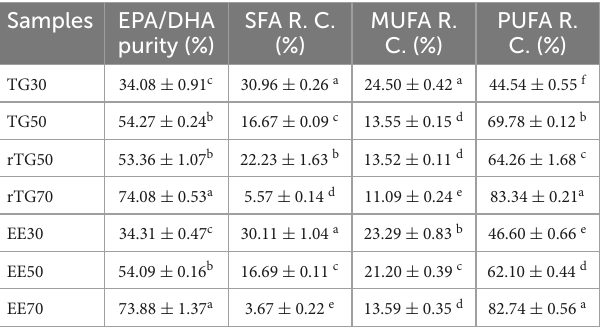
Valuesaremean ± SD, n =3.Valueswithdifferentsuperscriptsinsamerowdiffersignificantly ( p <0.05). Three EPA/DHA purities levels were set at 30, 50, and 70%, and performed